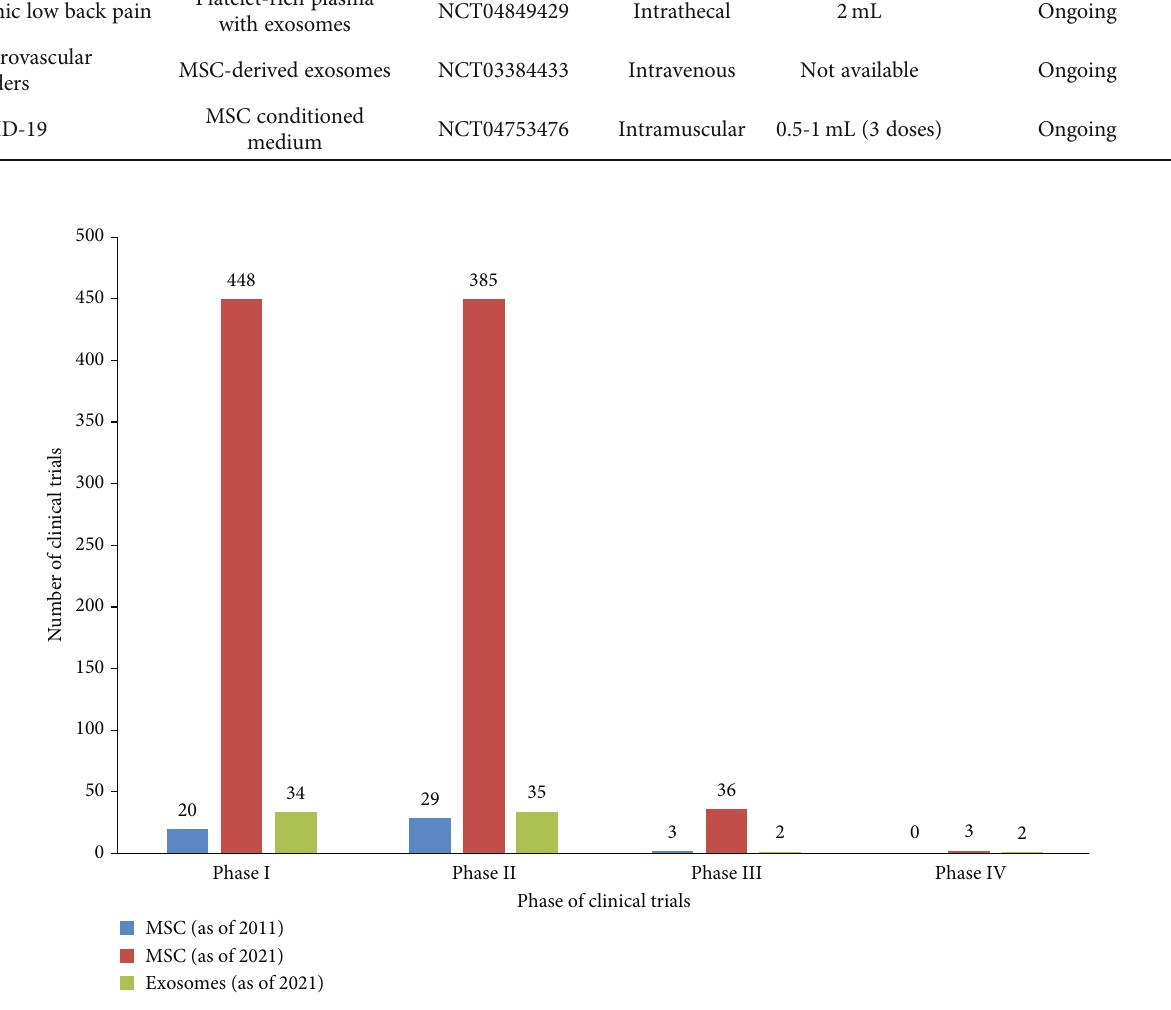
Figure 4: Number of mesenchymal stem cell (MSC) and exosome clinical trials between 2011 and 2021 by clinical phase (source: clinicaltrials.gov [accessed 5/5/2021]).